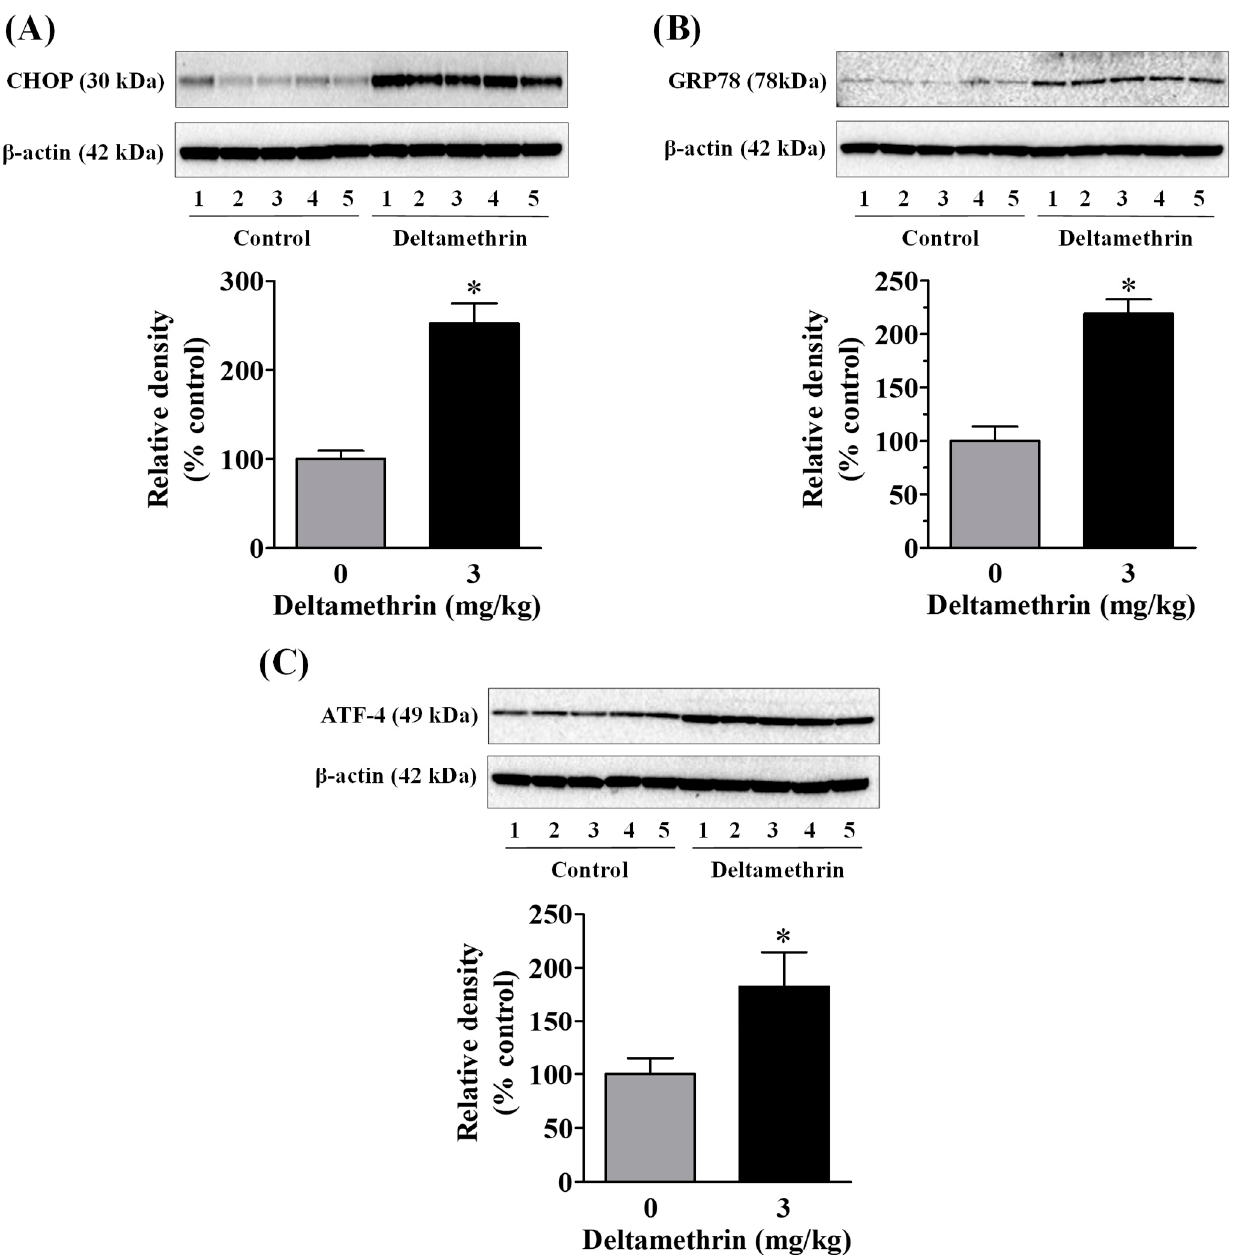
Figure 5. Deltamethrin exposure causes hippocampal ER stress in mice. Protein levels of CHOP ( A ), GRP78 ( B ), and ( C ) ATF-4 were determined by Western blotting. The protein bands were quantified by densitometry from Western blot analysis and the results reported as relative band densities in bar graphs. An asterisk denotes significant difference from control animals ( p < 0.05).